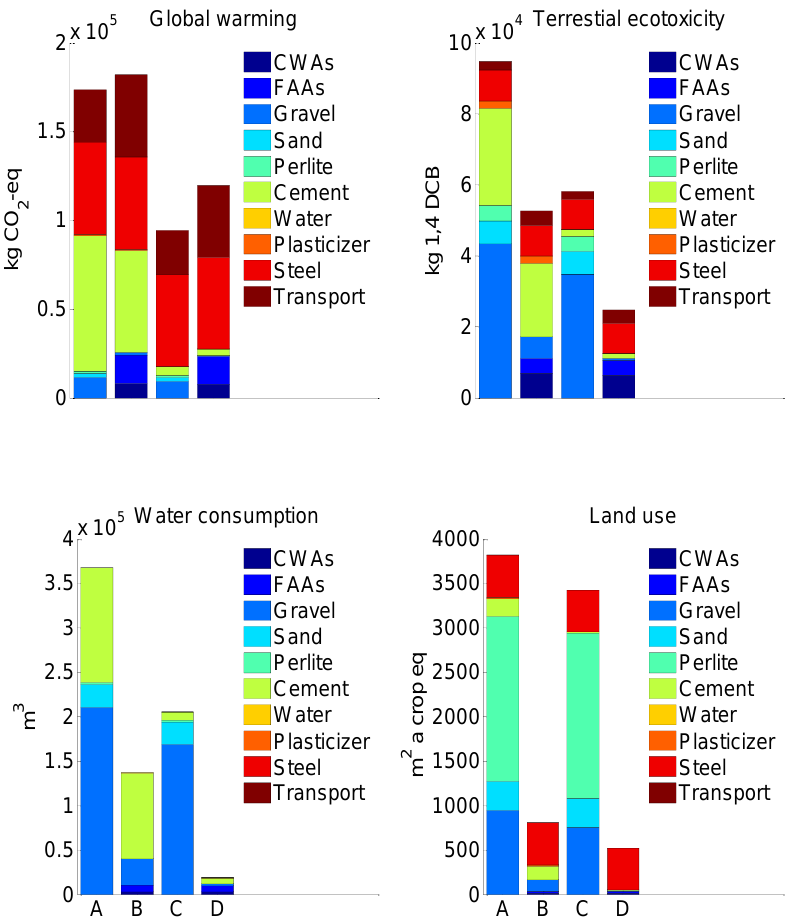
Figure 10. ( A ) Case 1: concrete wall strengthening (CWS)-conventional concrete + conventional green roof, ( B ) Case 2: CWS-waste-included concrete + waste-based green roof, ( C ) Case 3: seismic isolation columns (SIC)-conventional concrete + conventional green roof, and ( D ) Case 4: SIC-waste-included concrete + waste-based green roof evaluated with ReCiPe 2016 midpoint method.